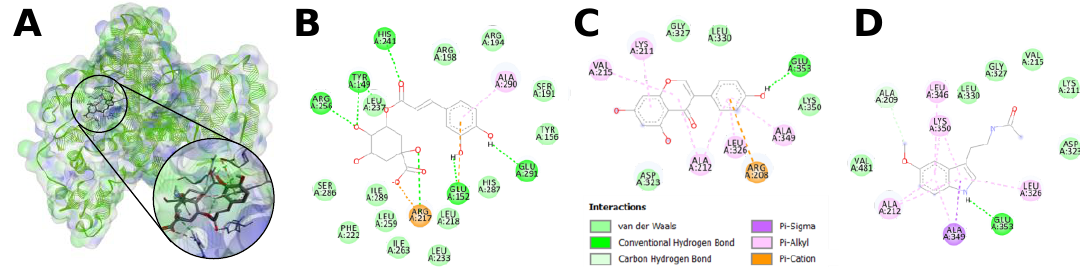
Figure 8. Representative molecular interaction of CGA with BSA ( A ), and 2D diagrams of the interaction of BSA with chlorogenic acid ( B ), genistein ( C ), and melatonin ( D ) determined using in silico molecular docking. The figure shows the compounds bound to the IIA domain of BSA and the interacting residues in each complex.